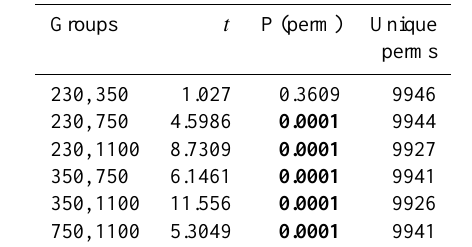
Table 4. PERMANOVA, Pair-wise tests for factor p CO 2 . Signifi- cant results are represented in bold.